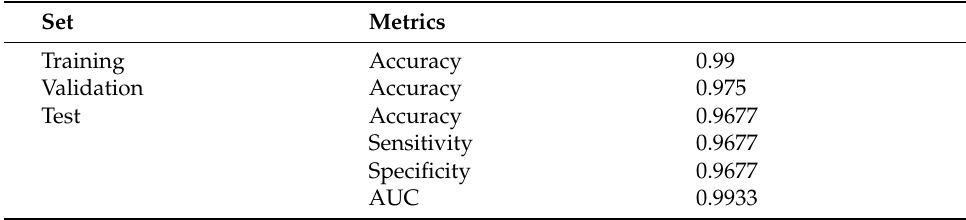
Figure 3. Model loss for the training and validation set.